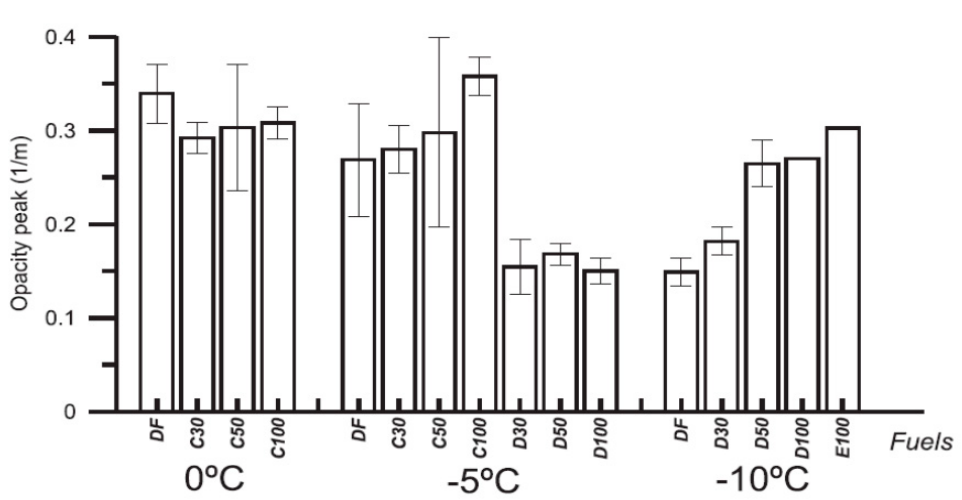
Figure 11. Opacity peak behavior for di ff erent biodiesel blends [50].